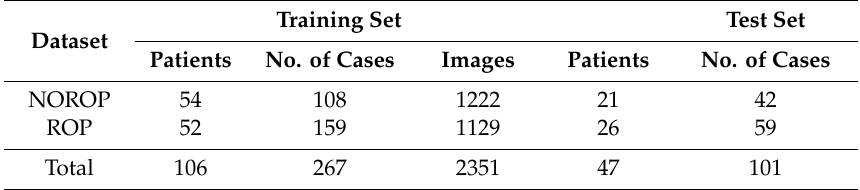
Table 2. NOROP (absence of ROP) and ROP (presence of ROP) dataset used for training and testing.